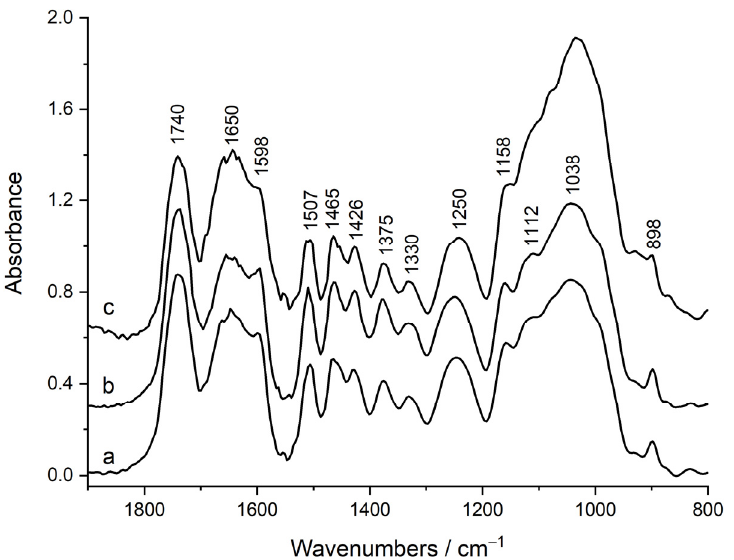
Figure 1. Examples of infrared FTIR spectra (SNV and baseline corrected) of chestnut samples representing the three location types, which are “INSIDE” ( a ), “NEAR” ( b ) and “FAR” ( c ) from the shallow landslide location.